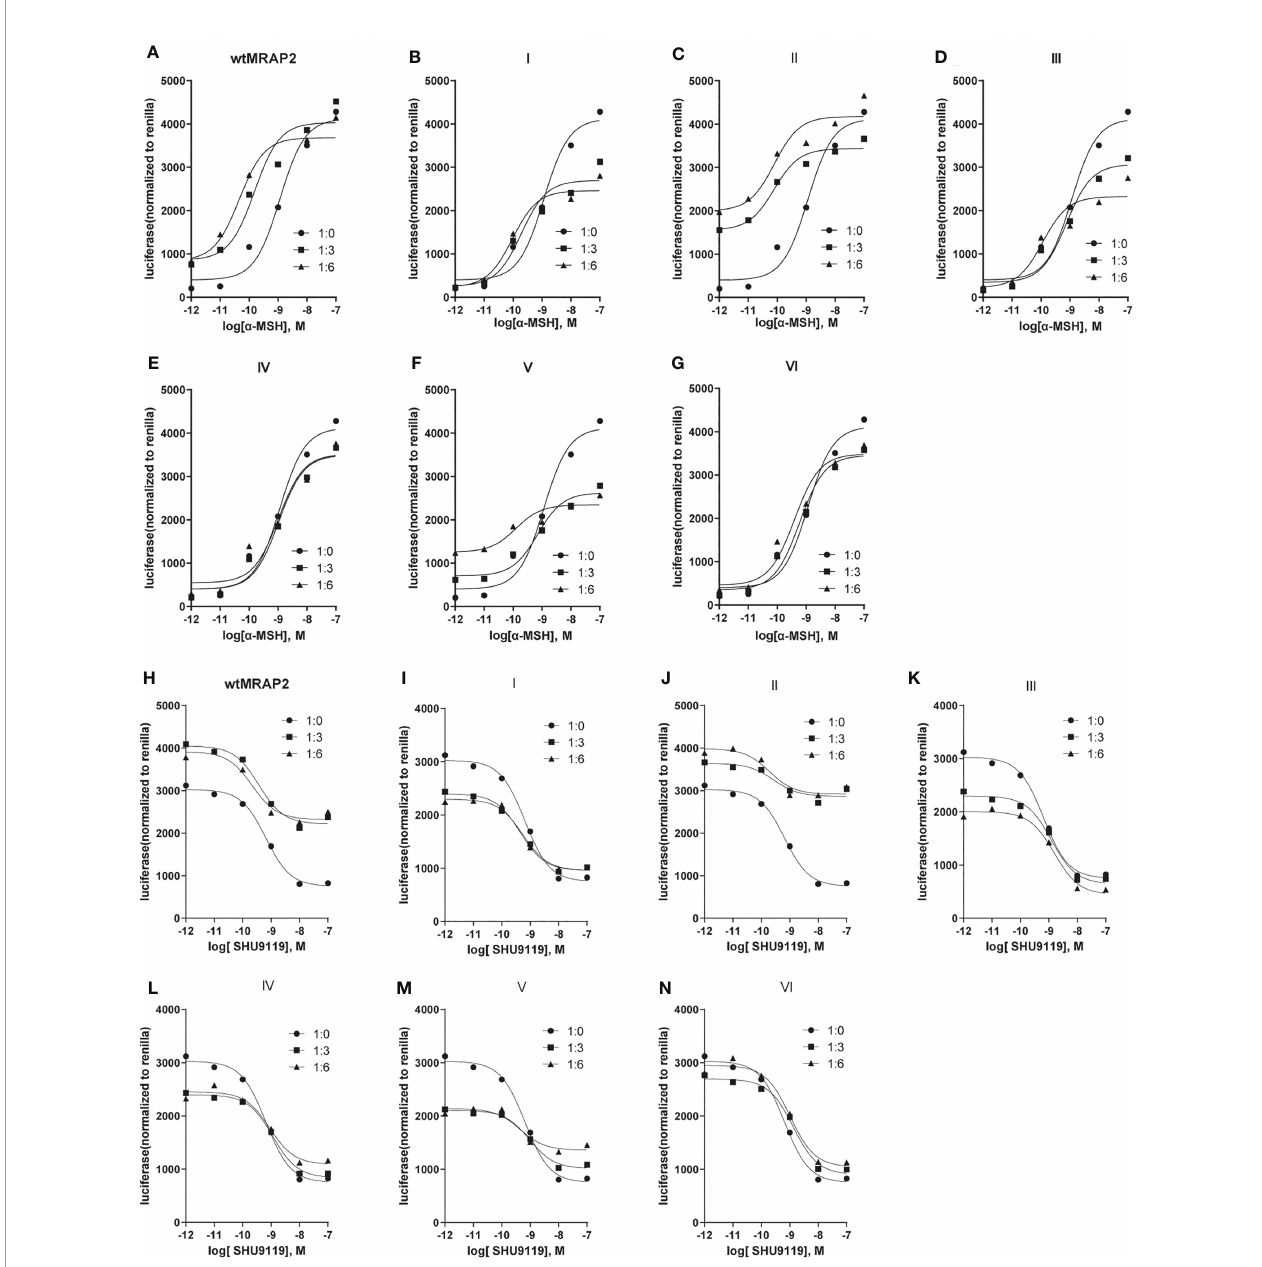
FIGURE 3 | Pharmacological modulation of melanocortin-4 receptor (MC4R) signaling by melanocortin receptor accessory protein 2 (MRAP2) variants. (A – G) cAMP response to increasing concentrations of alpha melanocyte-stimulating hormone ( a -MSH; 10 − 7 – 10 − 12 M) in HEK293T cells transfected with MC4R and an empty vector or in the presence of different ratios of MRAP2 or the MRAP2 variants (1:0, 1:3, and 1:6). Relative luminescence intensity of pCre-Luc represents the normalized pCre-Luc units to pRL-TK units (transfected internal control). (H – N) Binding competition of the agonist ( a -MSH) and antagonist (SHU9119) of MC4R modulated by the MRAP2 variants. The relative luminescence intensity of pCre-Luc represents the normalized pCre-Luc units to pRL-TK units (transfected internal control). Each data point represents the mean ± SEM of three replicates ( N = 3).